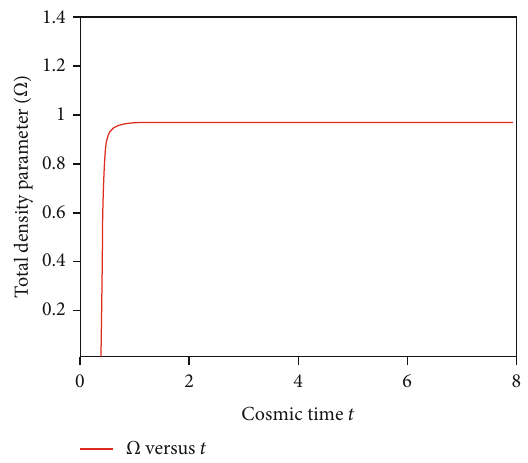
Figure 4: The plot of pressure of holographic dark energy versus cosmic time t for constants l = 1 : 5 , n = 2 , k = 0 : 5 , and m = 0 : 5 . 1